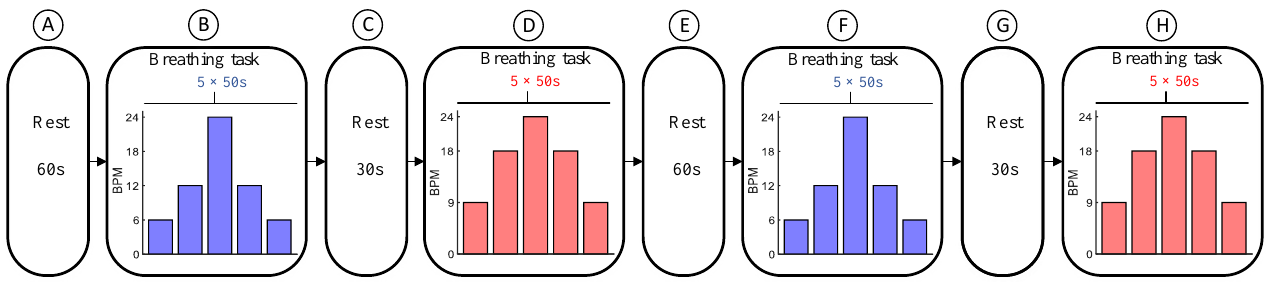
Figure 5. Data recording protocol. It consists of a resting period for 60 s ( A ), and two breathing control tasks lasting for 250 s ( B , D ), which are separated by a 30 s resting period ( C ). Subsequently, the same blocks were repeated ( E – H